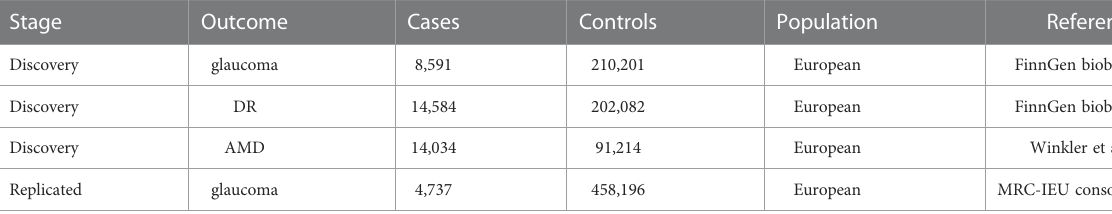
TABLE 1 GWAS samples of retinal neurodegenerative diseases used in MR